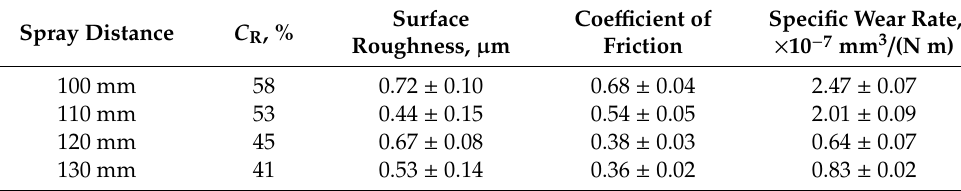
Figure 13. Influence of spray distance on the coating microstructure. Table 4. List of properties of coatings with different C R (H 2 O:isopropanol = 9:1).